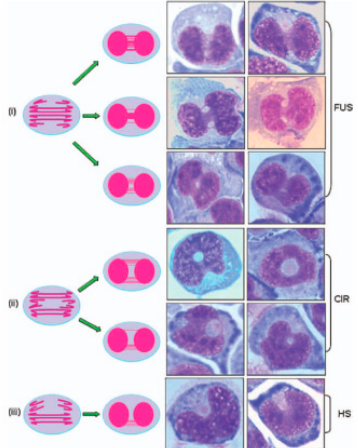
Figure 6. Typical appearances of the additional nuclear anomalies observed in the CBMN-Cyt assay. The nuclear anomalies: ( i ) fused (FUS), ( ii ) circular (CIR), or ( iii ) horseshoe (HS) nuclei. In the proposed models: ( i ) FUS nuclei originate as a result of multiple nuclear strands occurring uniformly or centrally between the nuclei of a binucleated (BN) cell, ( ii ) CIR nuclei originate as a result of multiple nuclear strands occurring on opposite sides between the nuclei of a BN cell, and ( iii ) HS nuclei originate as a result of multiple nuclear strands occurring only on one side between the nuclei of a BN cell. In each of these models, the total combined width of the connections between the nuclei in a BN cell is typically larger than one-fourth of the nuclear diameter—the maximum width of a conventional NPB, as defined within the CBMN-Cyt assay [13]. For the sake of simplicity, the conceptual diagrams only show a representative fraction of chromosomes. This figure was reproduced from Bull et al. [31], with permission from Wiley Periodicals,